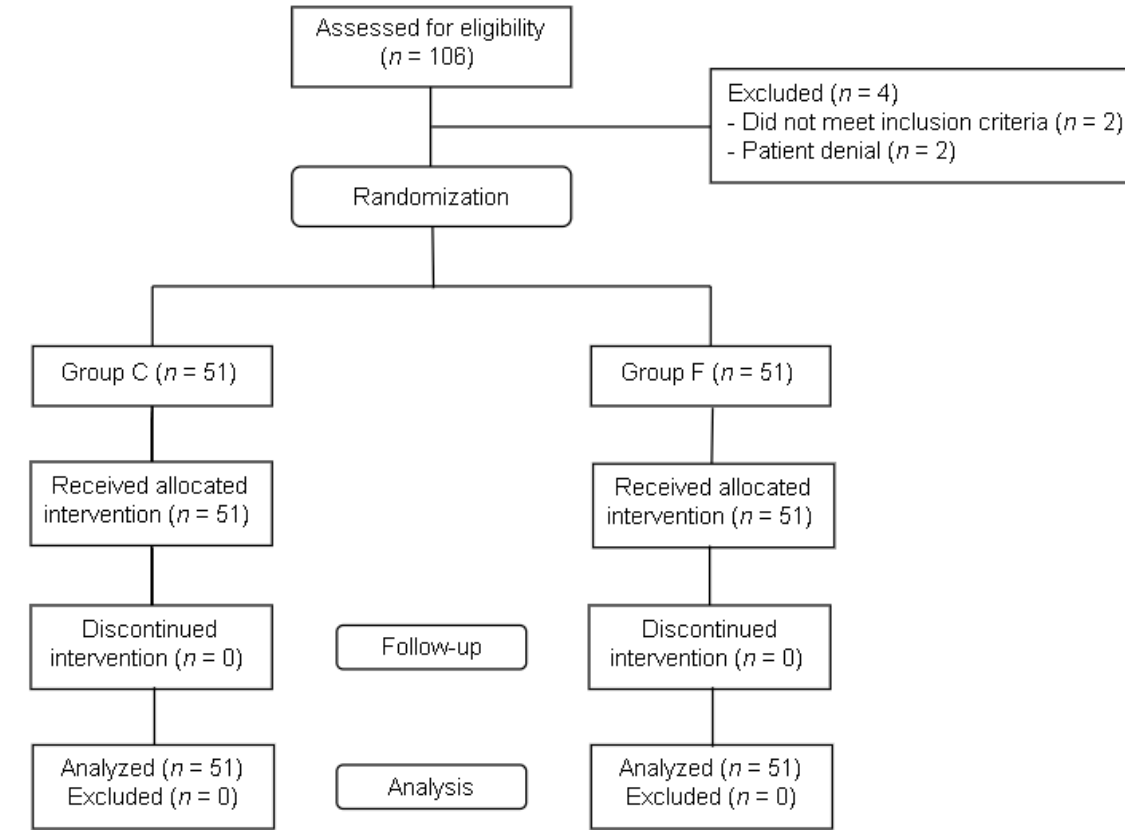
Figure 1. Flowchart of enrollment and randomization of the study. Table 1. Demographic features of participants and duration of surgery.